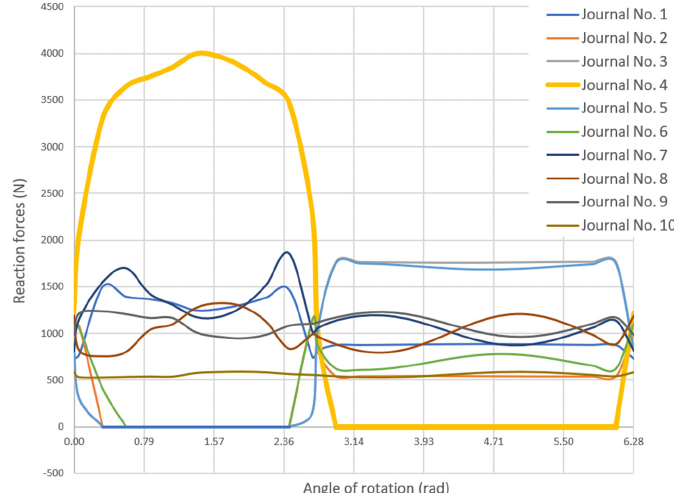
Figure 18. Variation of the support reaction forces for the case where journal No. 4 shows the eccentricity e = 55 µm, while the support is lowered in relation to the others by x = − 11 µm.